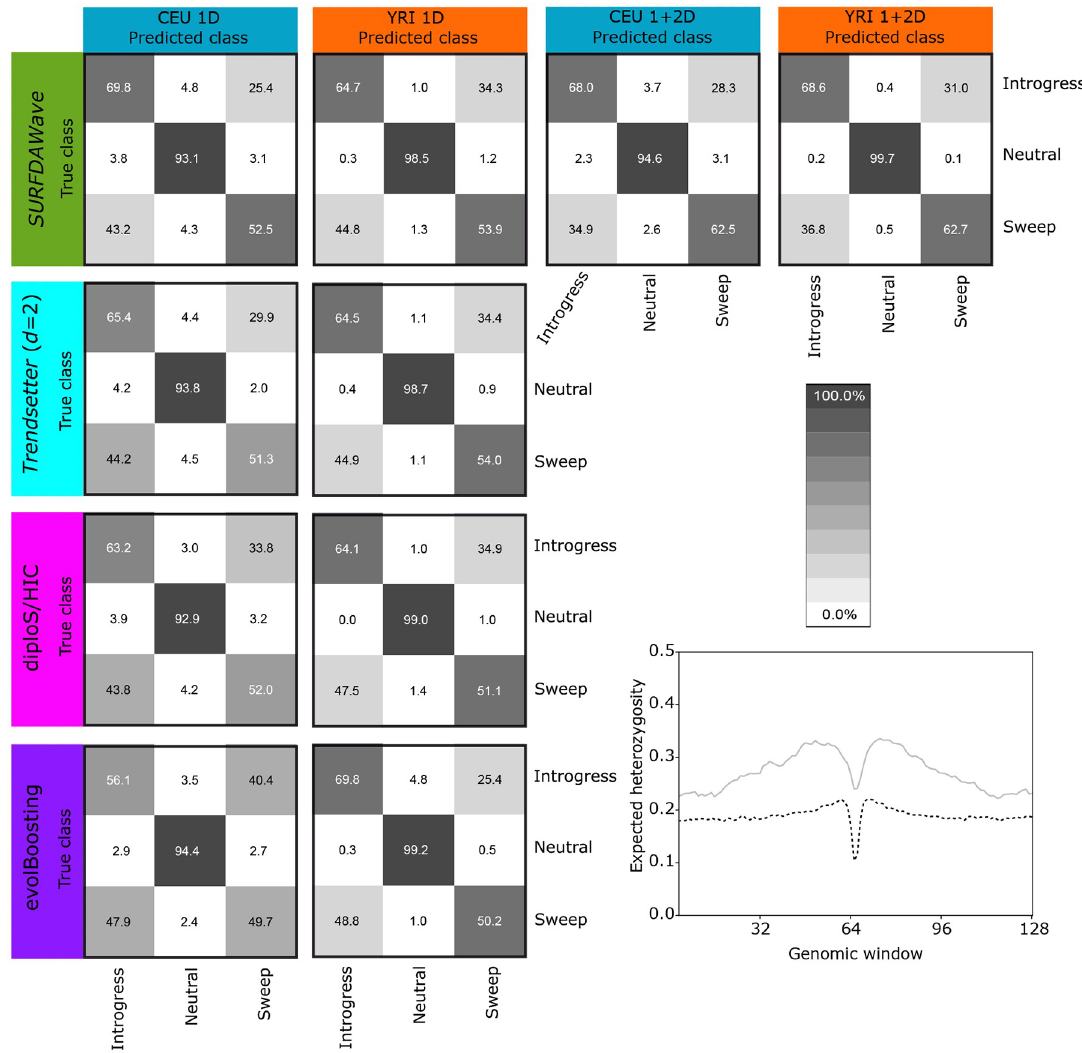
Fig 4. Classification rates when differentiating among adaptive introgression, sweeps, and neutrality. (Top row) SURFDAWave classification rates. The two first columns are showing classification rates when trained and tested with simulations conducted under CEU European and YRI Yoruban population demographic history specifications when trained with one-dimensional statistics ( ^ p , H 1 , H 12 , H 2 / H 1 , and frequencies of first to fifth most common haplotypes) while the second two columns show results for the same two populations using both one and two-dimensional statistics (including the preceding statistics as well as the mean, varaiance, skewness, and kurtosis of r 2 ). The γ for the classifiers trained with only the one dimensional statistics is chosen through cross validation (see Training the models ), but is specified γ = 1 for the results in the two columns on the right. The level is chosen through cross validation for all SURFDAWave models. (Bottom three rows of confusion matrices) Confusion matrices comparing classification rates for Trendsetter , diploS/HIC, and evolBoosting with simulations conducted under European (CEU) and Yoruba (YRI) demographic history specifications. Summary statistics ^ p , H 1 , H 12 , H 2 / H 1 , and frequency of the first, second, third, fourth, and fifth most common haplotypes used by Trendsetter . (Bottom right) Value of expected heterozygosity across simulated regions of adaptive introgression with varying divergence times. The black dotted line shows the value of the statistic when the divergence time is shorter (30,000 generations ago) and the gray line shows the value when the divergence time is longer (400,000 generations